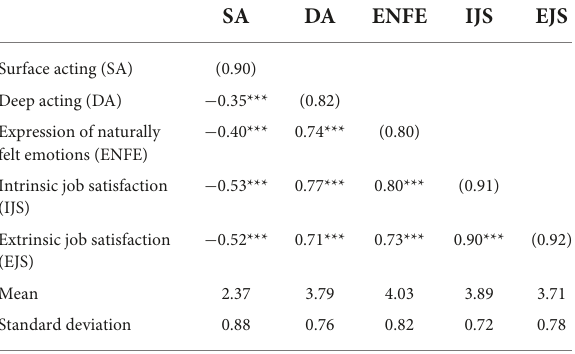
TABLE 1 Descriptive statistics and correlations among variables.